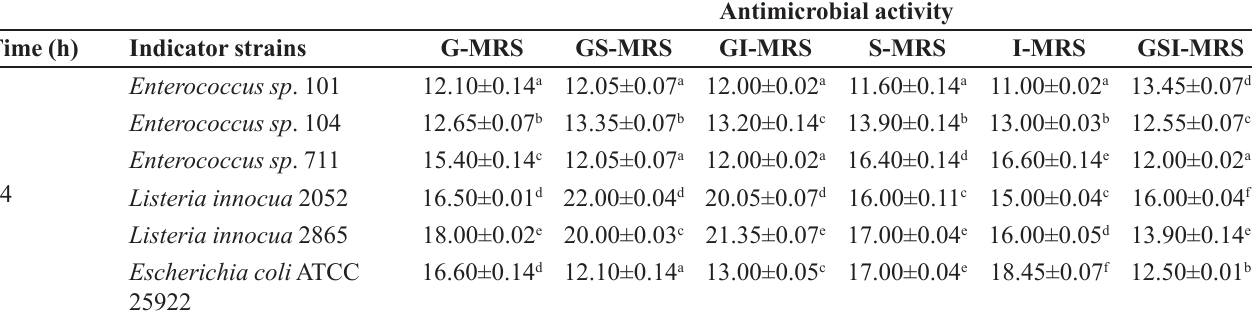
Legend: G-MRS = glucose-based MRS medium, GS-MRS = glucose + sucrose-based MRS medium, GI-MRS = glucose + inulin- based MRS medium, S-MRS = sucrose-based MRS medium, I-MRS = inulin-based MRS medium, GSI-MRS = glucose + sucrose + inulin-based MRS medium. Mean values (n=3) ± standard deviations. Different letters in the same column mean that values significantly differ among them ( p ˂ 0.05)